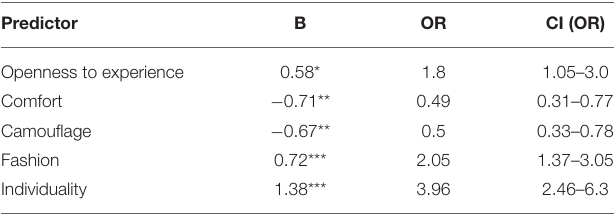
TABLE 6 | Multiple logistic regression analysis to predict urban style vs. casual style of dress ( N =